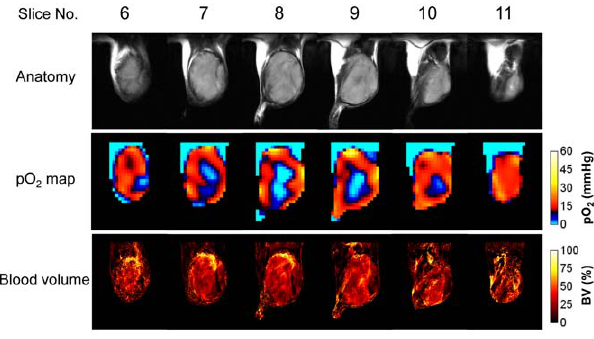
Figure 2. Anatomy, pO 2 , and blood volume images of SCC tumor. T 2 -weighted anatomical image (top) of a SCC tumor-bearing mouse, and the corresponding pO 2 maps (middle) and blood volume images (bottom) measured by EPRI and MRI. The adjacent center six slices of the 3D images were displayed, and the every slice has 2 mm